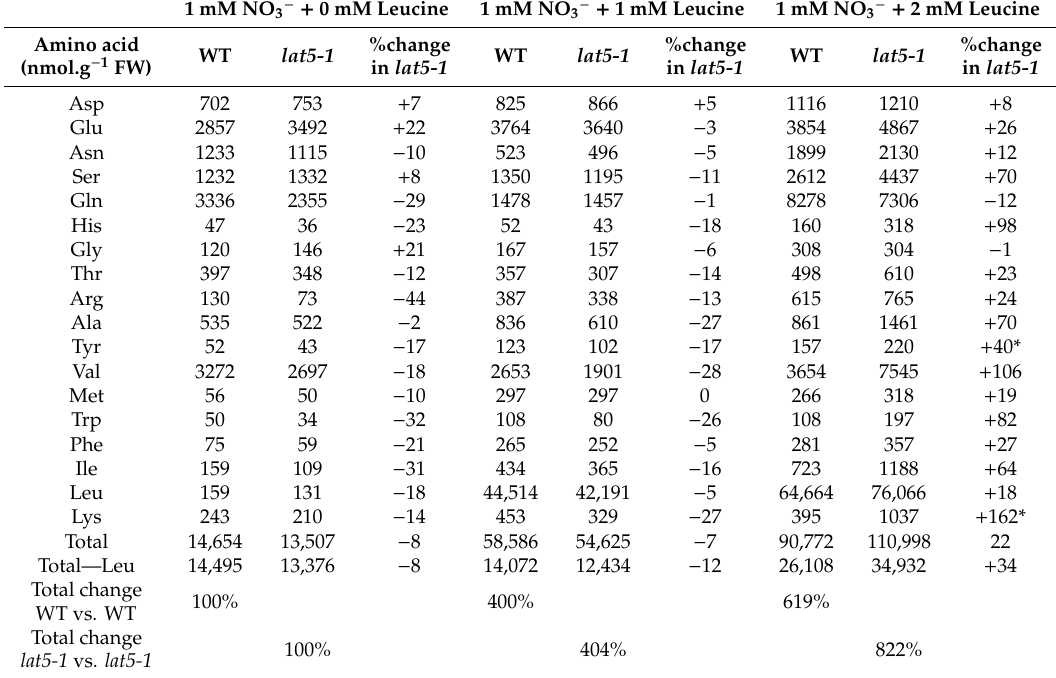
Table 1. Free amino acid analysis in the homozygous lat5-1 seedlings grown on nitrate and